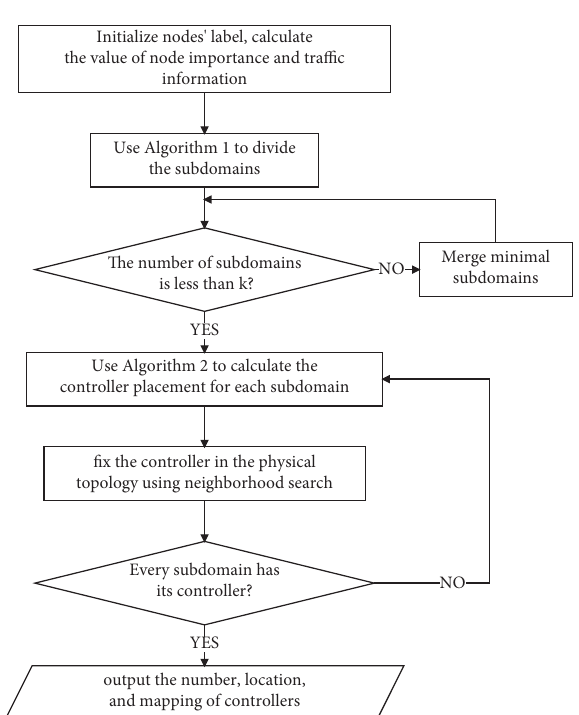
Figure 2: The flow diagram of the placement